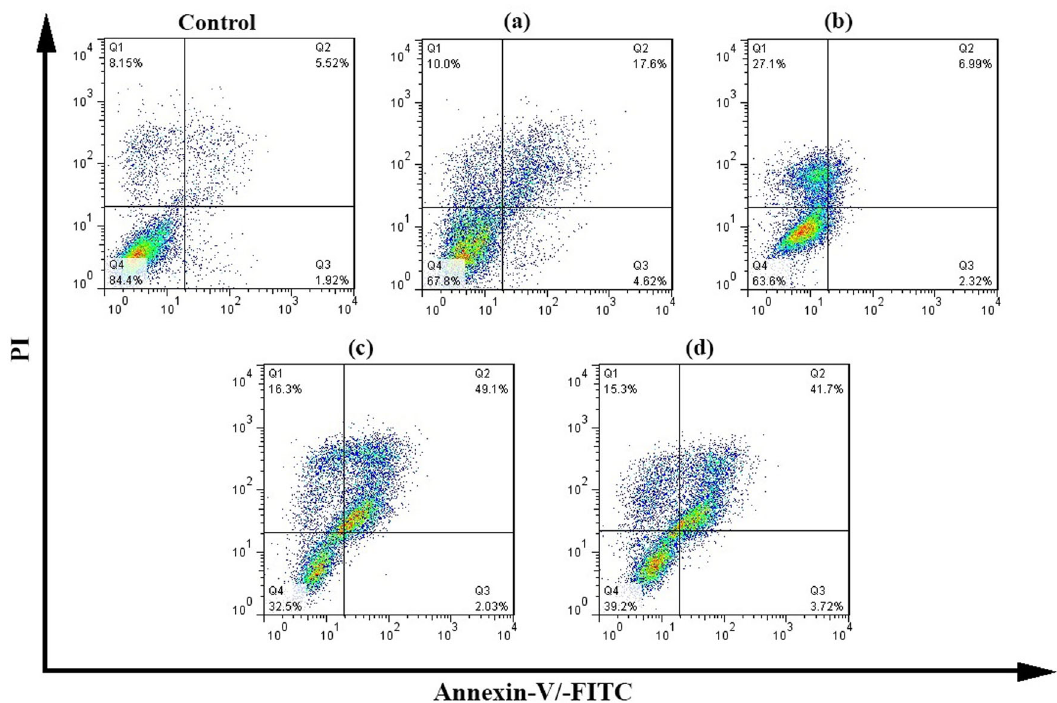
Fig. 12 Annexin-V/-FITC/PI Flow cytometry analysis of MCF-7 breast cancer cells treated with the prepared hydrogels. a CS-g-gly, ( b ) CMCS-g-gly, ( c ) CS-g-gly loaded with vincristine, and ( d ) CMCS-g-gly loaded for 48 h. The lower left (Q4) (Annexin − PI − ) and the lower right (Q3) (Annexin + PI − ) quadrants represent viable cells and early apoptotic cells. The upper right region (Q2) (annexin + PI + ) and the upper left (Q1) (annexin − PI + ) represent late apoptotic cells and necrotic